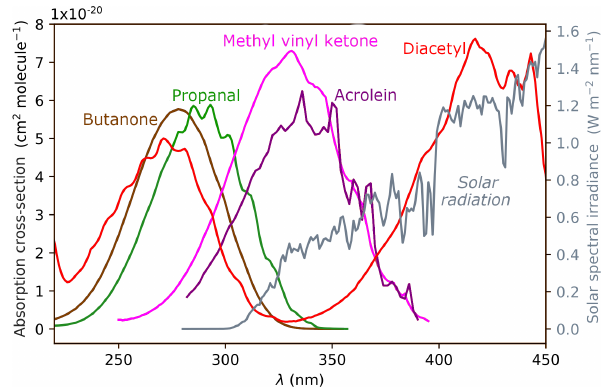
Figure 1. UV absorption spectra of representative carbonyls: aldehydes (represented by propanal), ketones (butanone), enals (acrolein), enones (methyl vinyl ketone) and α -dicarbonyls (di- acetyl). The solar spectrum is shown in grey, plotted against the right